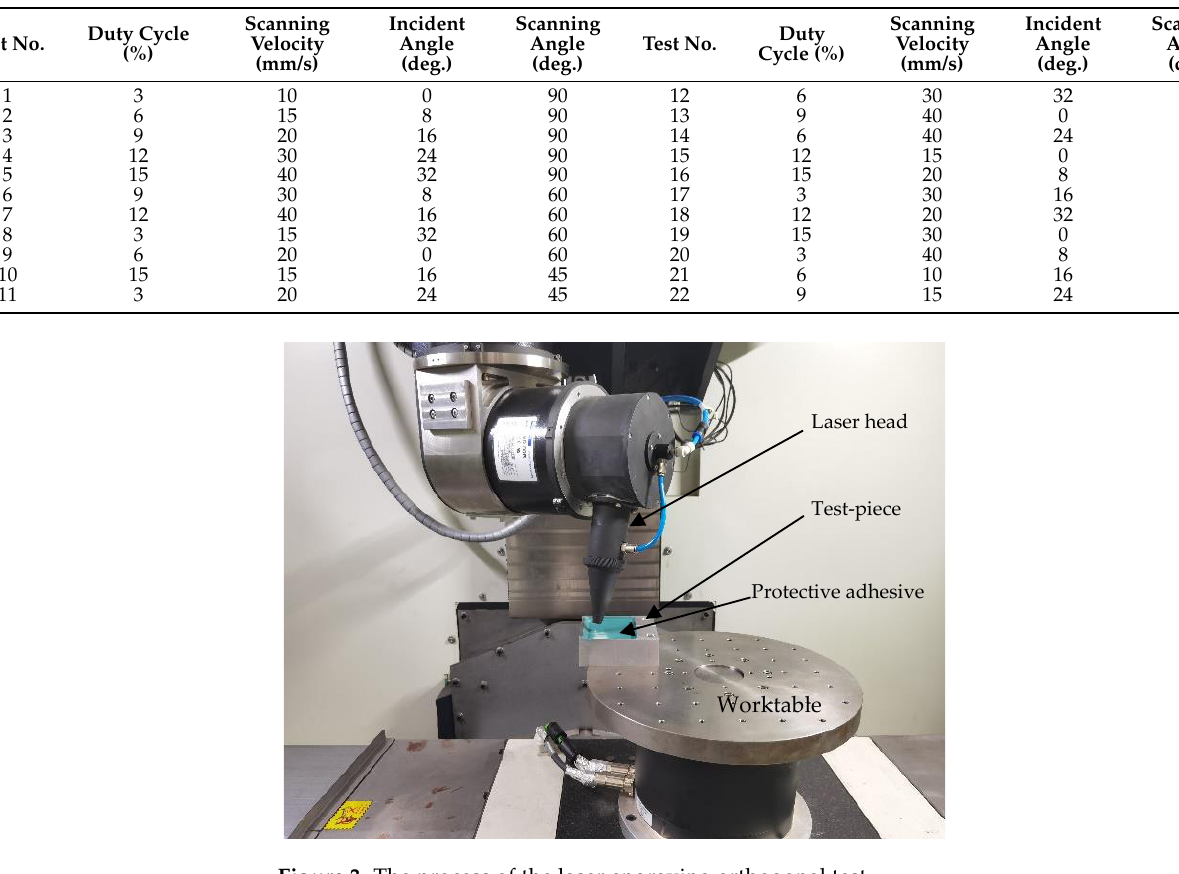
Figure 3. The process of the laser engraving orthogonal test.